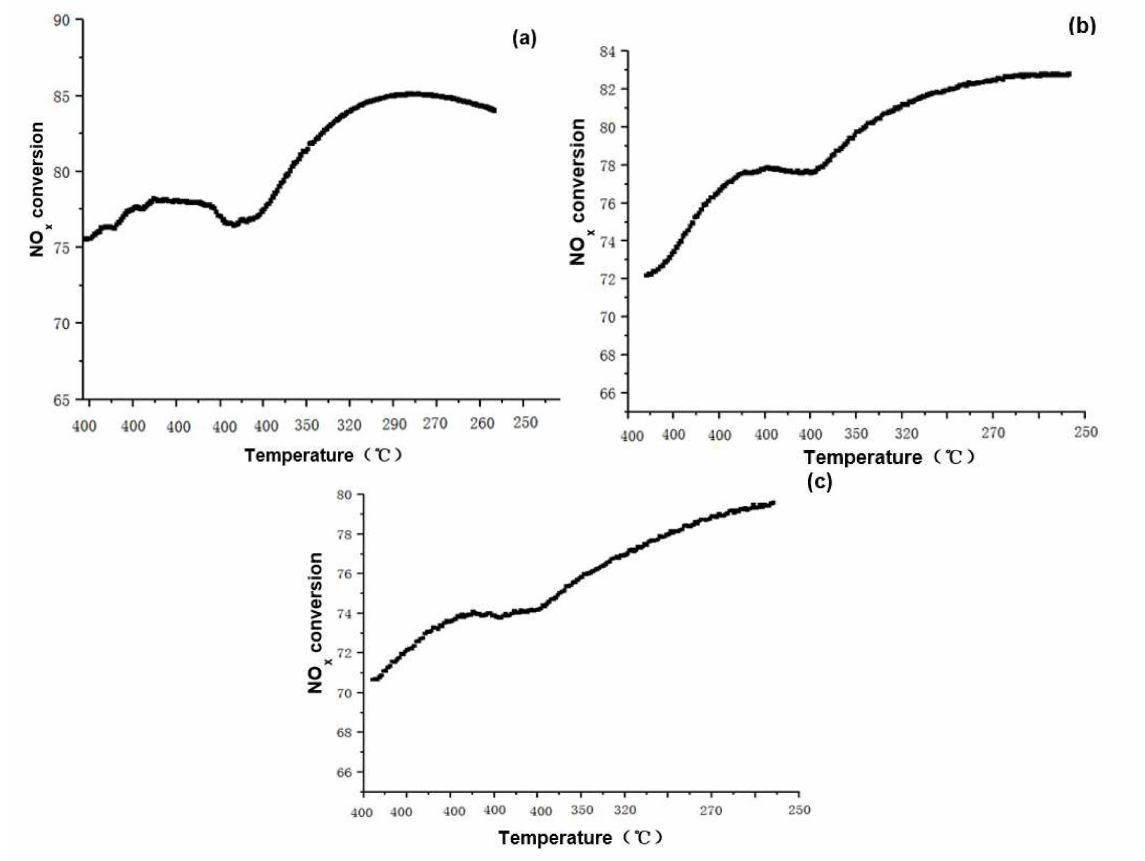
Figure 11. Curve of NO x conversion with temperature. ( a ) The first experiment; ( b ) The second experiment; ( c ) The third